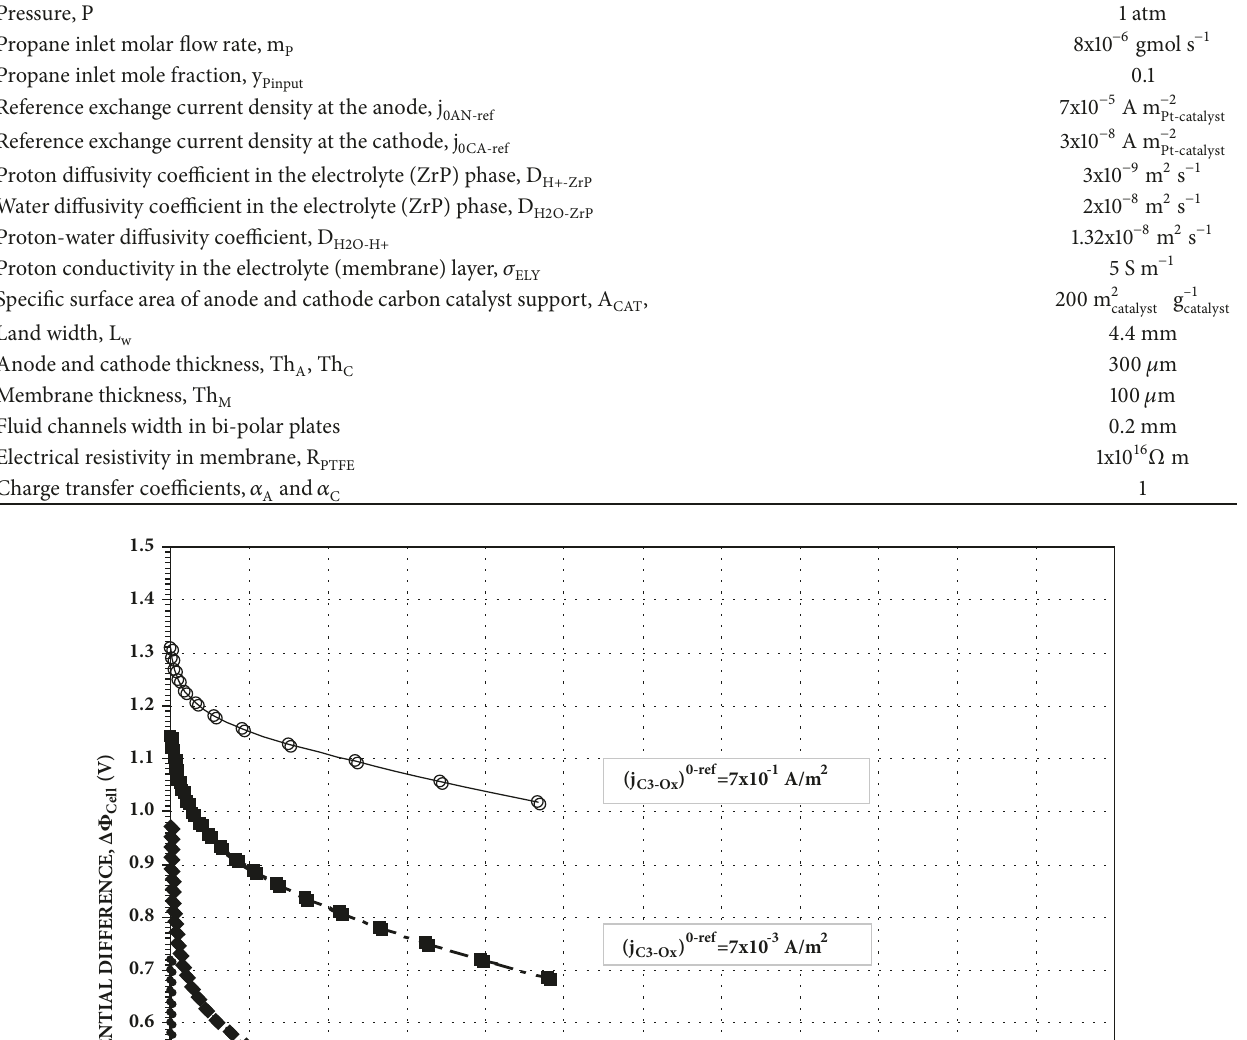
Table 1: Operational, electrochemical, and design parameters of the reference case of the DPFC model (see [28]). Parameter Value Temperature, T 423 K Pressure, P 1 atm Propane inlet molar flow rate, m P Propane inlet mole fraction, y Pinput Reference exchange current density at the anode, j 0 AN - ref Reference exchange current density at the cathode, j 0 CA - ref